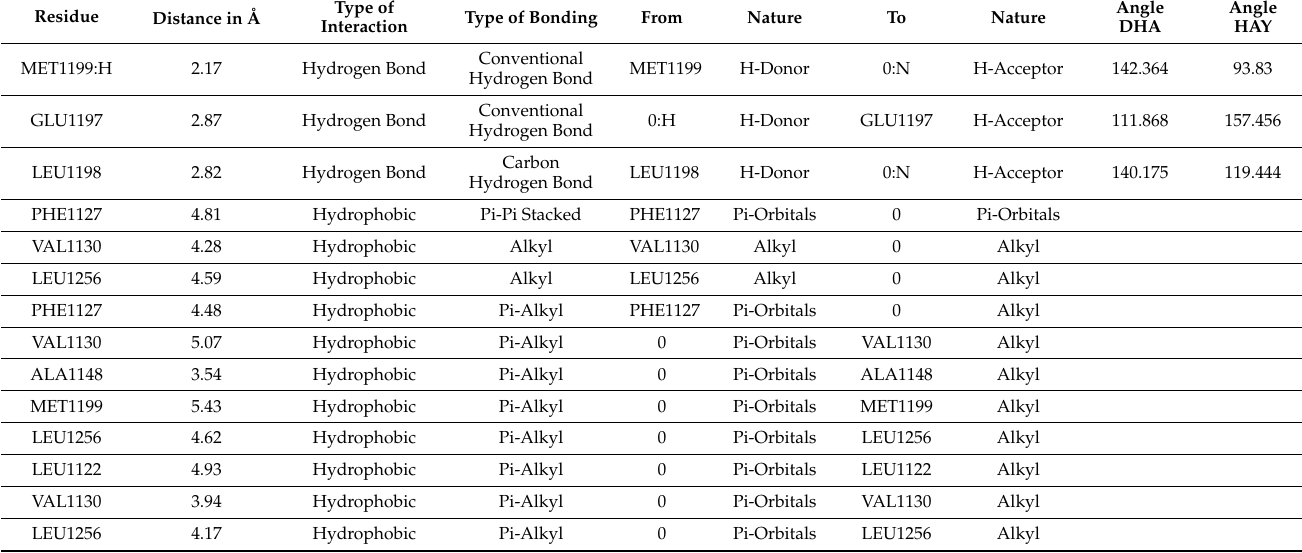
Table 2. Presentation of docking interactions of the compound